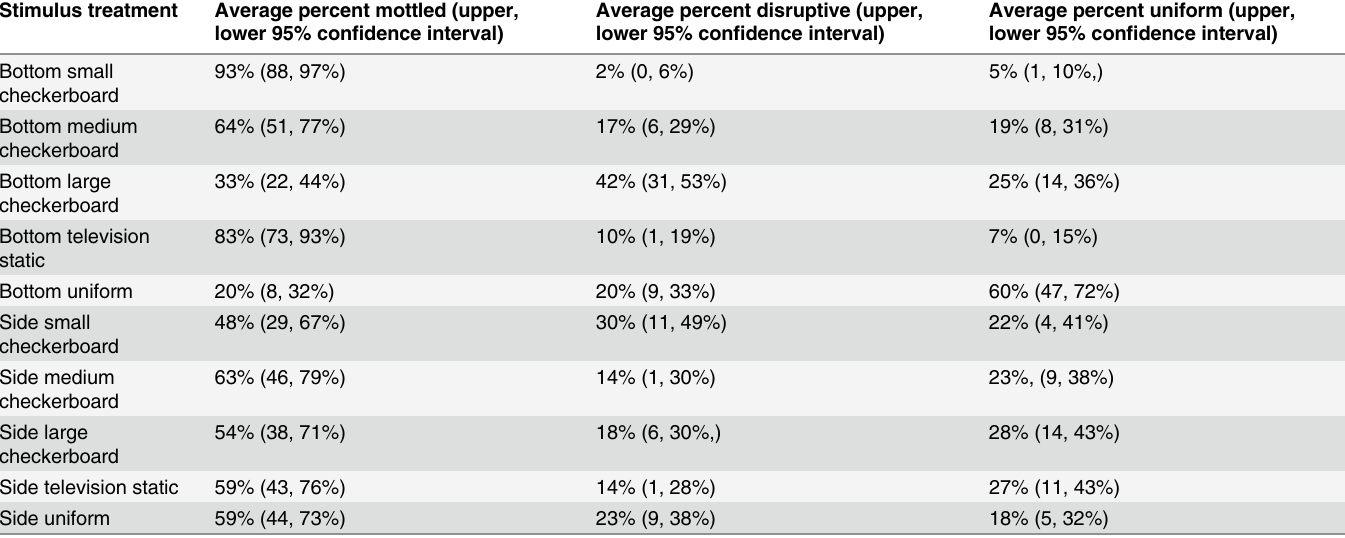
Table 1. Average percent classification of disruptive, mottled, and uniform for each of the bottom and side stimuli treatments. Stimulus treatment Average percent mottled (upper, Average percent disruptive (upper, lower 95% con fi dence interval) lower 95% con fi dence